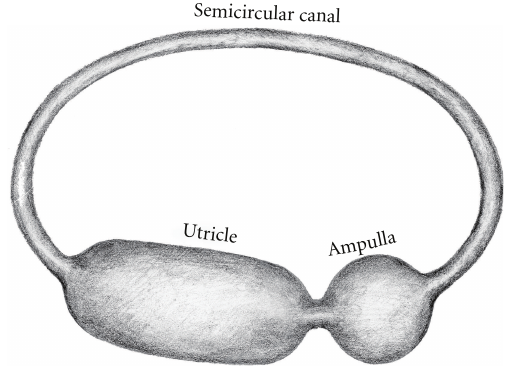
Figure 3: Model of the basic vestibular membranes (after